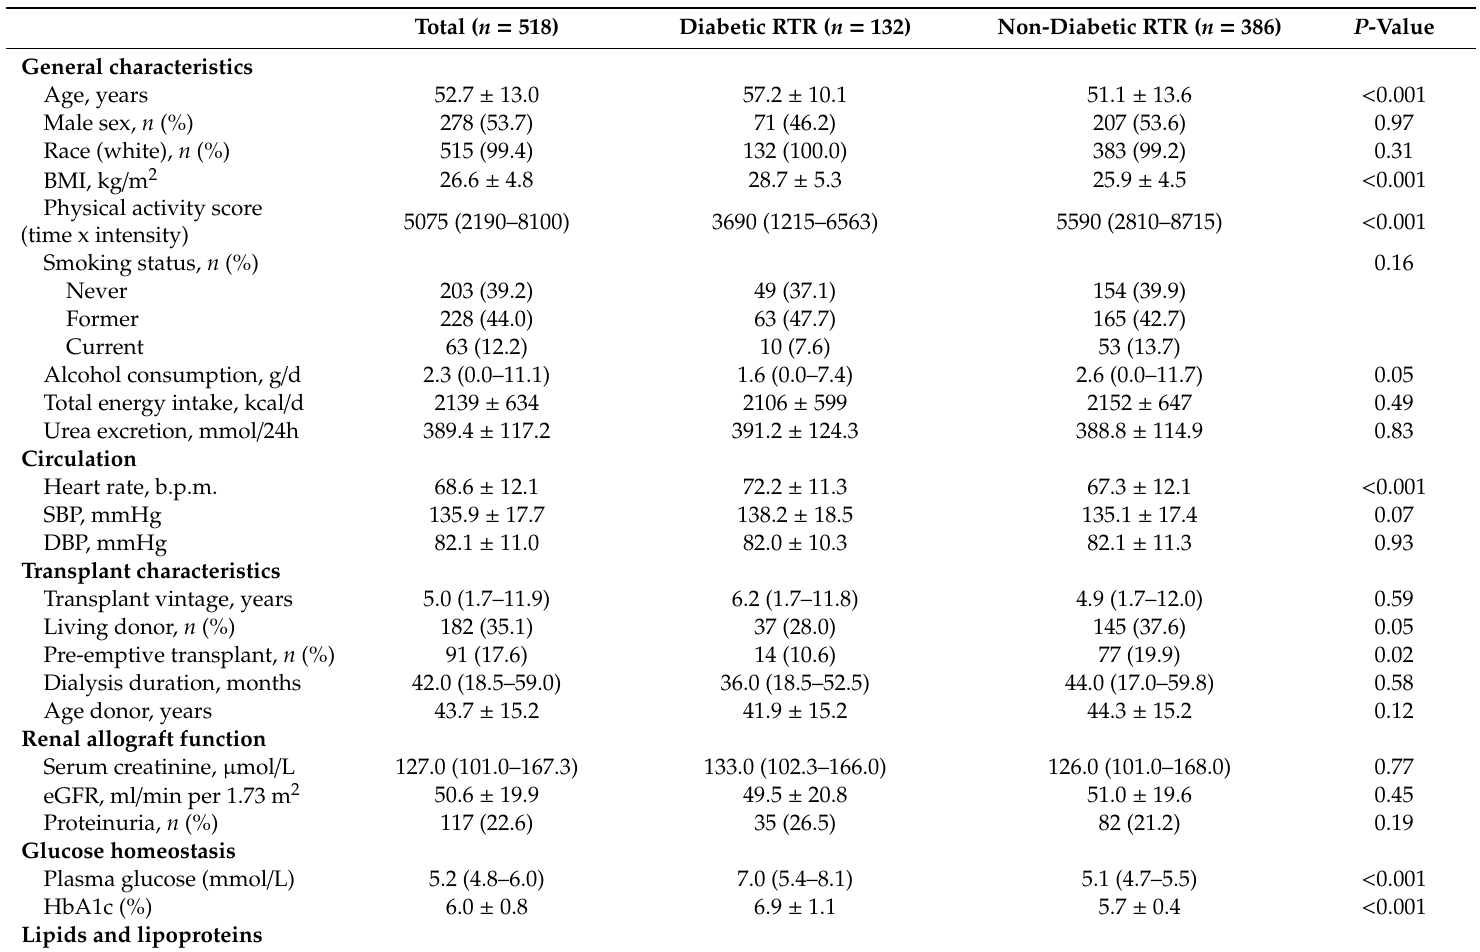
Table 1. Baseline characteristics in renal transplant recipients ( n =